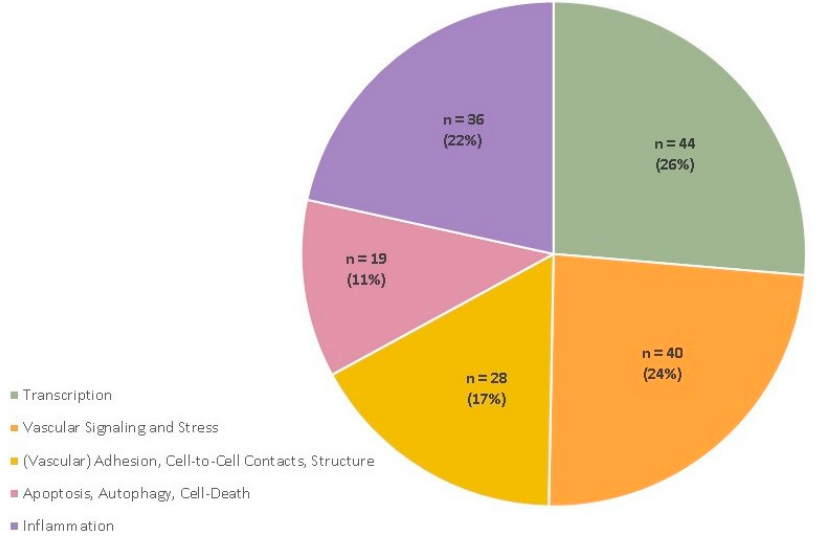
Figure 2. Number of papers per topic. Note that several papers provided input on multiple topics— therefore the absolute number is higher than number of